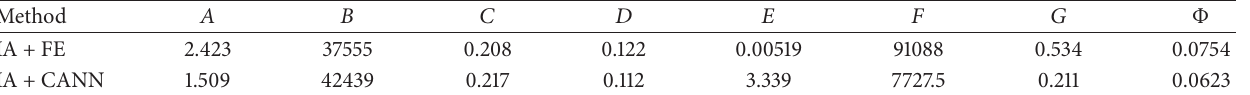
Table 8: Coefficients in (4) determined for DP600 steel using classical inverse analysis with FE model and inverse analysis with the clasterized ANN as metamodel.